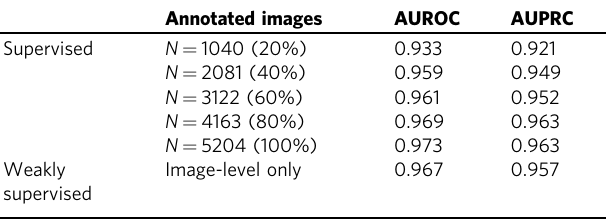
Table 4 The comparison of models trained using different numbers of physician annotated images. The weakly supervised method uses only image-level